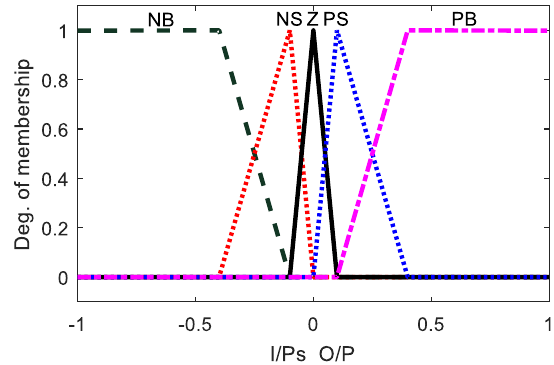
Fig. 5 Membership function of error and change of error of